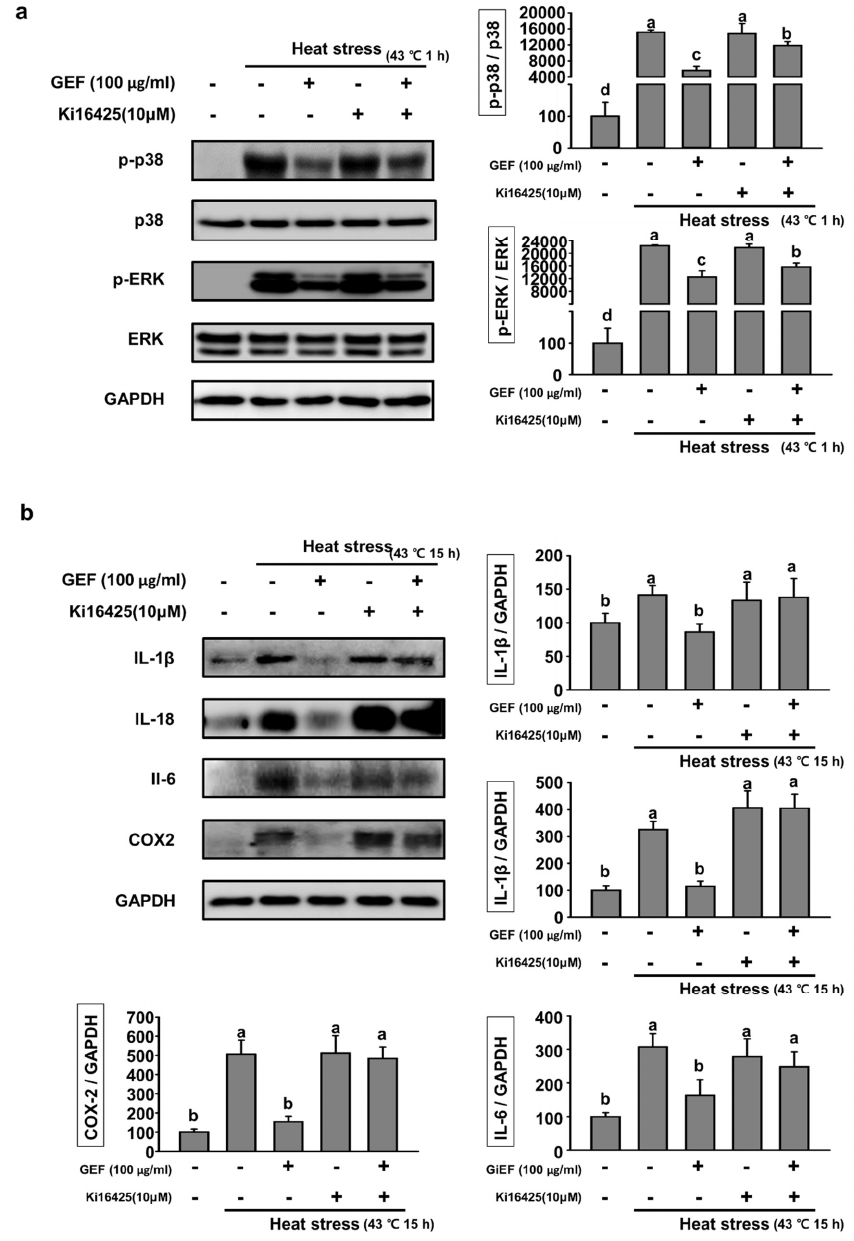
Figure 4. Expression of MAPK signaling factors and inflammatory cytokines with antagonist and GEF on heat stress ( a ) Analysis of antagonist (Ki16425) on p-p38 and p-ERK expression by Western blot. Quantification of p-p38 per total p38 was represented by a bar graph and quantification of p-ERK per total ERK was represented by a bar graph. ( b ) Expression of inflammatory cytokines treated with antagonist and GEF at heat stress. Analysis of the e ff ect of antagonist on IL-18, IL-1 β , IL-6 and COX-2 expression by Western Blot. Quantification of IL-18, IL-1 β , IL-6 and COX-2 per GAPDH was represented by a bar graph, respectively. Values labeled with di ff erent letters are significantly di ff erent ( p <